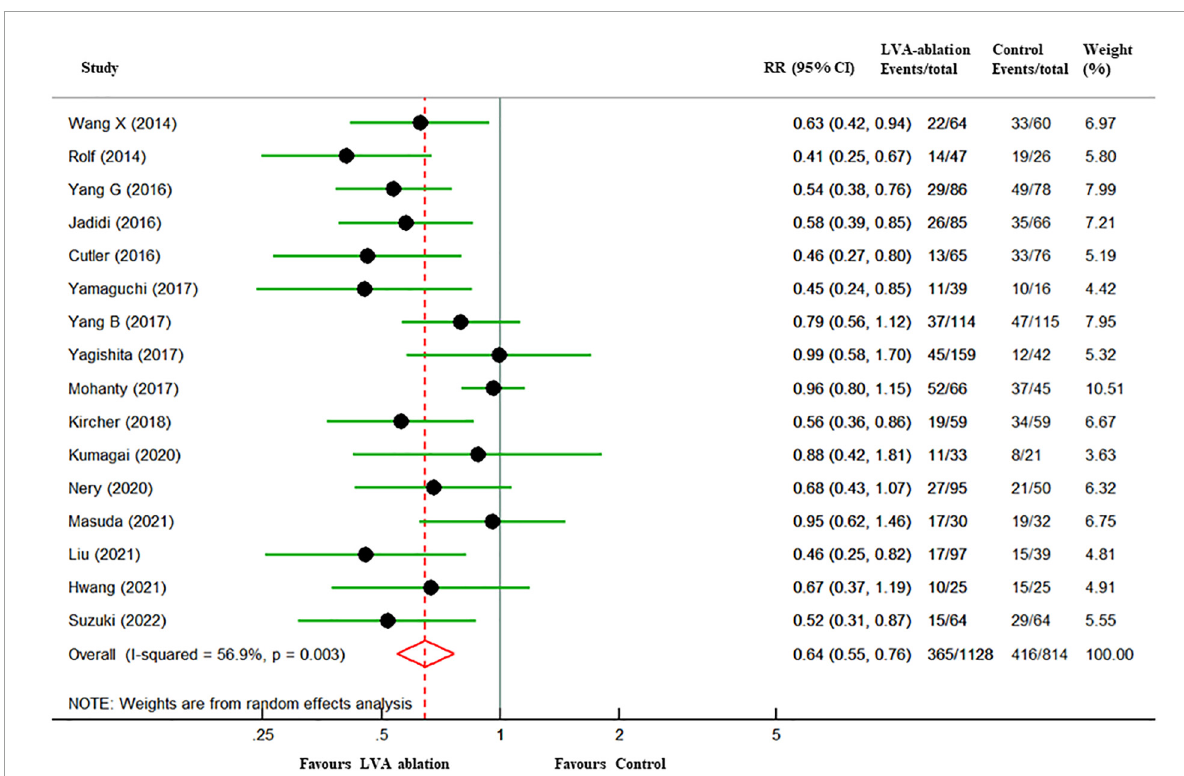
FIGURE2 Forest plots of all-atrial tachycardia recurrence among patients with LVA-guided substrate modification ablation compared with those who underwent control ablation. The size of the circle-plotting symbol is proportional to the size of the study. Horizontal lines are the 95% CI. LVA, atrial low-voltage areas; RR, risk ratios; CI, confidence